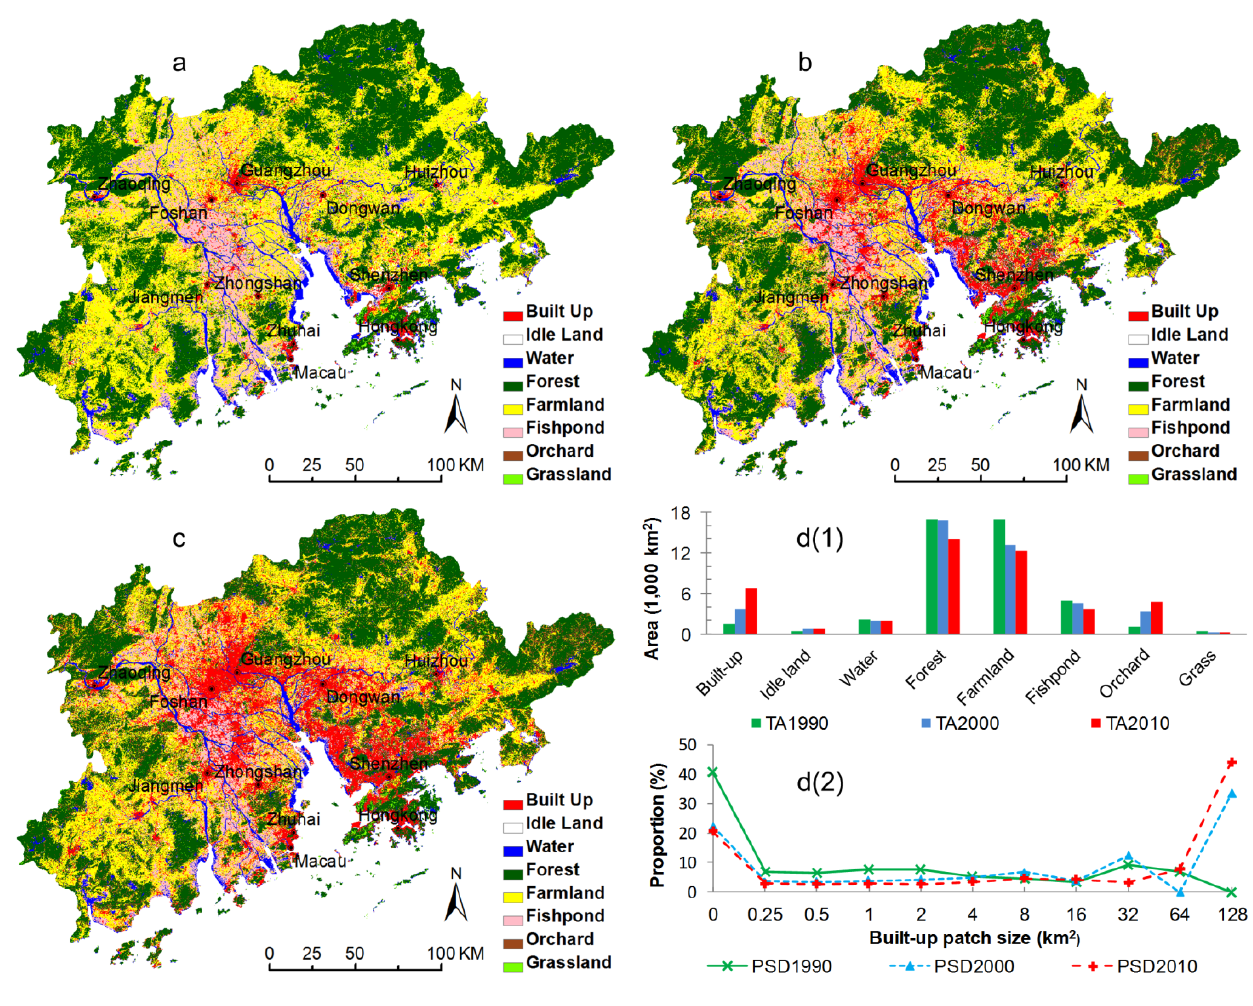
Figure 3. Land use maps for 1990 ( a ), 2000 ( b ) and 2010 ( c ), and the quantitative changes of each land use type ( d ( 1 )) and the variation of built-up lands among different patch sizes ( d ( 2